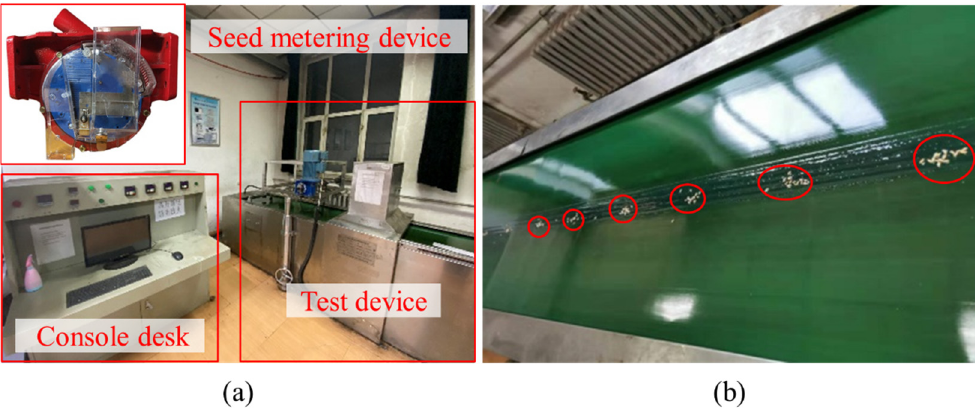
Figure 4. Bench test: ( a ) test device; ( b ) test result.